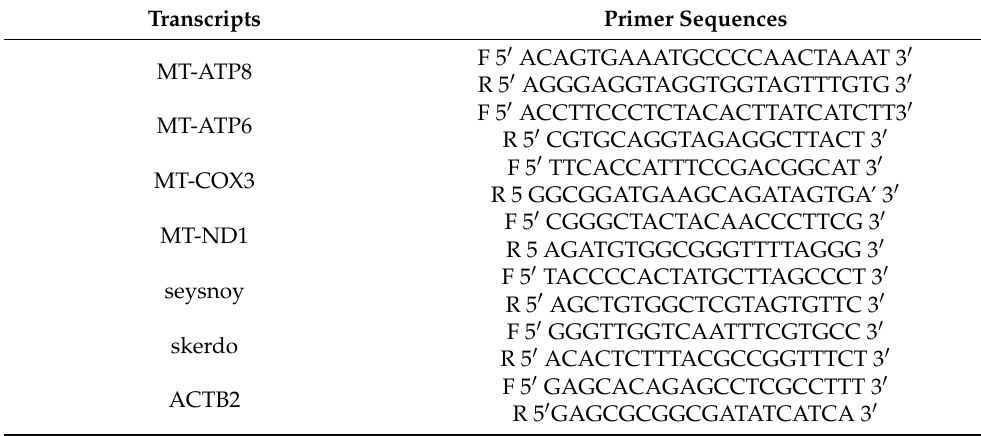
Table 5. Primer sequences of transcripts analyzed through